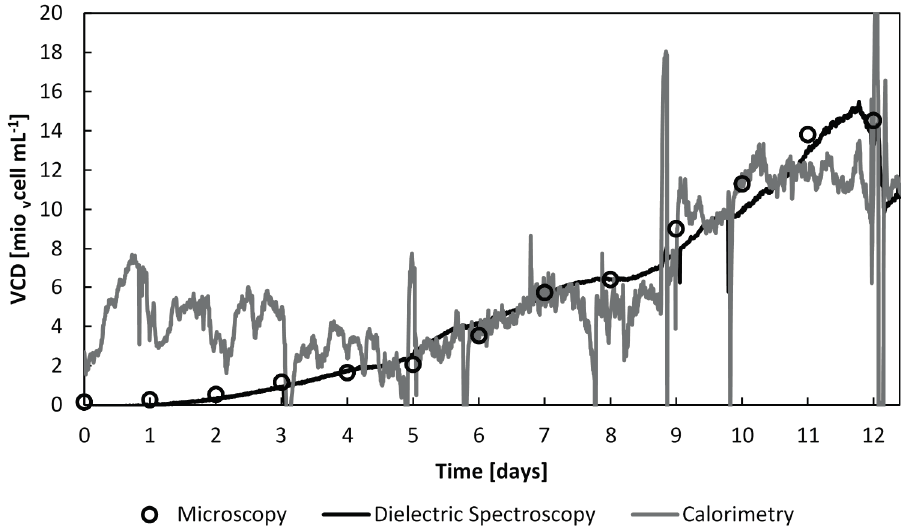
Figure 11. The viable cell density evolution throughout the whole culture time estimated by off-line cell counts, dielectric spectroscopy and